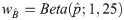
Power comparison for FamBAC and FamKAC when causal variants are in the same direction of effects on age-at-onset (AAO) trait.Power was estimated based on 1,000 replicates under the following parameter settings: (A) censoring rate: 0.1, 0.2, 0.3, and 0.5; (B) Vg: 5, 10, 15, and 20; (C) number of trios: 1, 000, 2, 000, 3, 000, and 4, 000; (D) Pcv: 9.1, 0.3, 0.5, 0.7, and 1 under Vg fixed at 5; (E) Pcv: 0.1, 0.3, 0.5, 0.7, and 1 under fixed Vcv for all causal variants, where Vcv is derived based on Vg = 5 and 50% of rare variants being causal. The default parameter setting for all simulations is 30% censoring rate, Vg = 5, 2, 000 trios, and Pcv = 30%. Method notations are the following: FamBAC: FamBAC with no variant weight w0 = 1; FamBACB: FamBAC with variant weight wB^=Beta(p^;1,25) where p^ is the sample minor allele frequency (MAF) estimated from the between-family component Gb; FamKAC: FamKAC with w0; FamKACB: FamKAC with variant weight wB^.